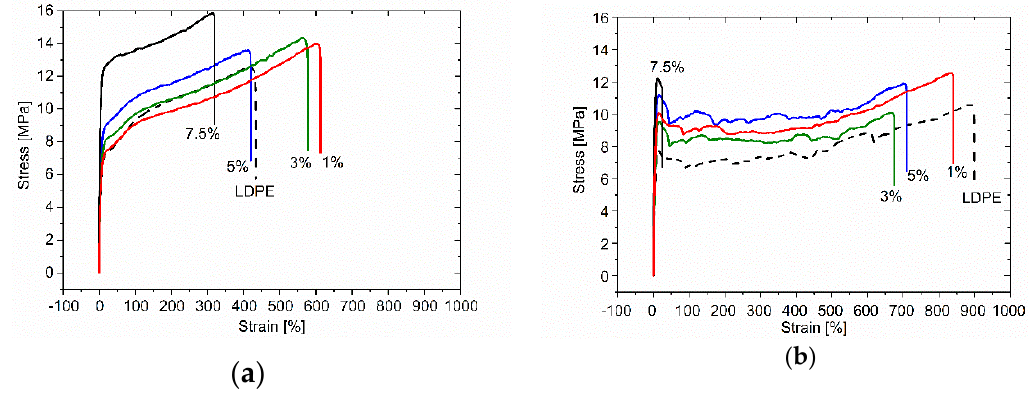
Figure 9. Stress-strain curves measured for reference LDPE and LDPE-GnP nanocomposites; parallel to the extrusion direction ( a ) and perpendicular to the extrusion direction ( b ).